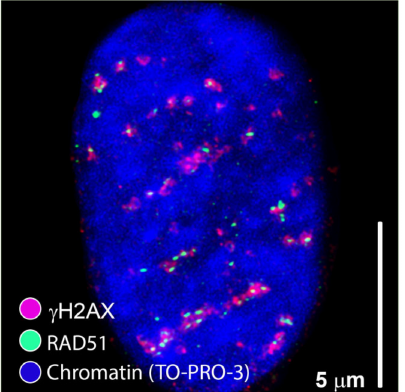
Figure 2. HR in a representative cell exposed to high-LET radiation. A G2-phase nucleus in a normal human skin fibroblast irradiated with 15 N ions (182.9 keV/ µ m, 13.0 MeV/n, 10 ◦ angle between the ion beam and the cell monolayer) and fixed 4 h post irradiation is displayed with immunofluorescently labeled γ H2AX (red) and RAD51 (green) repair foci (i.e., IRIFs). As demonstrated by the figure and extensive literature, HR seems to be a preferred repair pathway in G2 cells exposed to high-LET radiation. However, not all DSBs in this single nucleus are being repaired by this (preferred) pathway (note the γ H2AX sites that are not colocalized with RAD51), suggesting that cells must consider numerous globally and locally acting factors (see Figure 1) when selecting a particular pathway at individual damage sites. In other words, each damage site may be repaired via a different mechanism even under the influence of factors that confer a global preference for one particular pathway. A maximum image composed of superimposed individual optical confocal slices (0.05 µ m thick) acquired with a Leica SP5 microscopy system (Leica) is shown after deconvolution using Lightning (Leica) software. Chromatin-dense (“heterochromatin”, stained intensely blue) and chromatin-sparse (“euchromatin”, weakly stained) domains are visualized with blue fluorescence